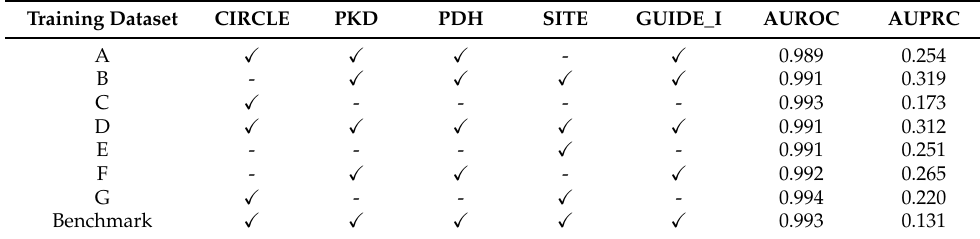
Table 4. Performance of R-CRISPR with different training datasets on Dataset GUIDE_II. Training